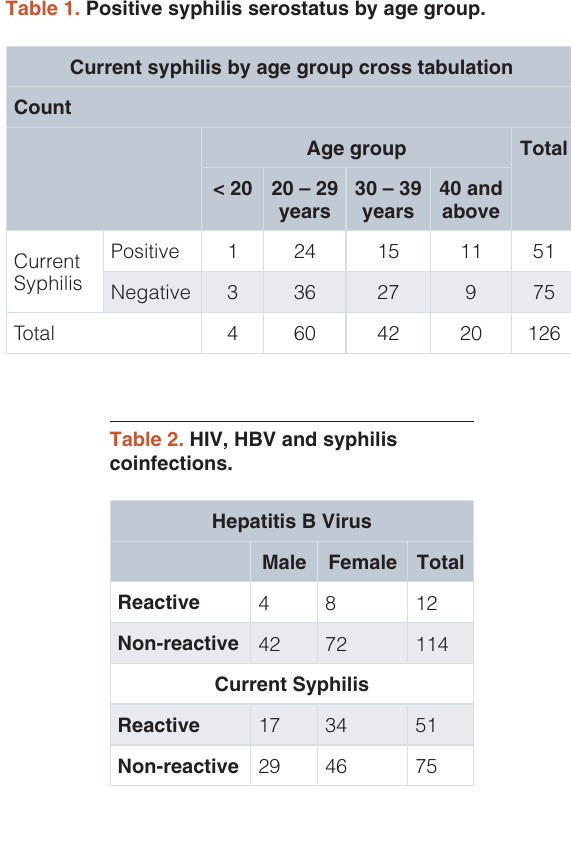
Table 3. Past vs current syphilis risk estimate.